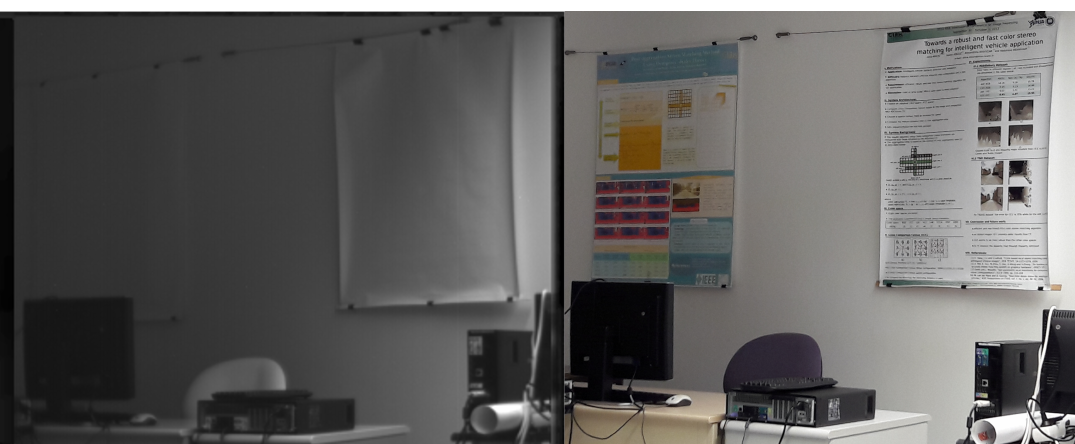
Figure 3. Serigraphy in visible and infrared spectra: whereas the printed shapes are discernible in the visible spectrum, the posters seem blank in the infrared spectrum.